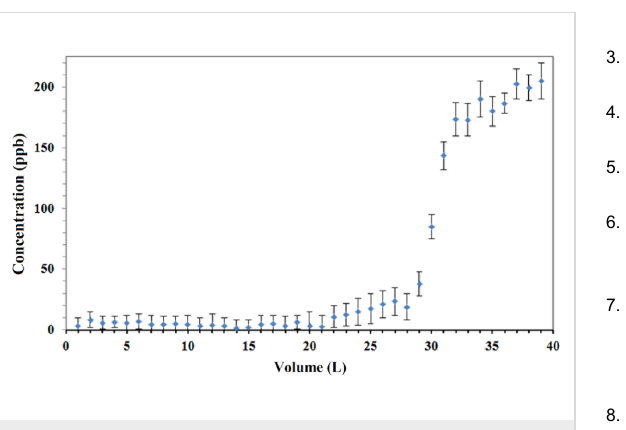
Figure 8: Performance of an adsorptive membrane in the removal of chlortetracycline from aqueous